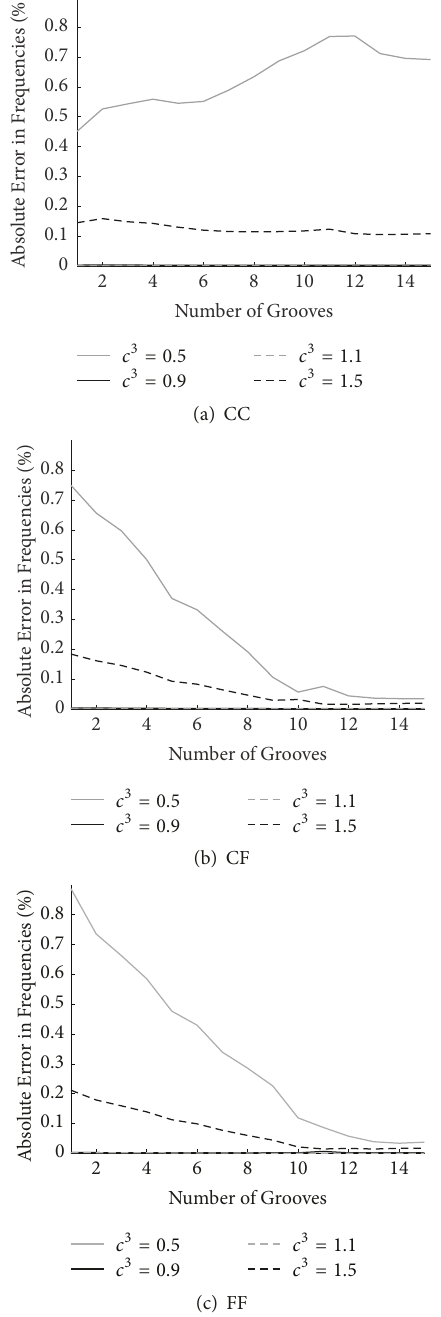
Figure 16: Frequency errors for variable groove number and norm minimization of